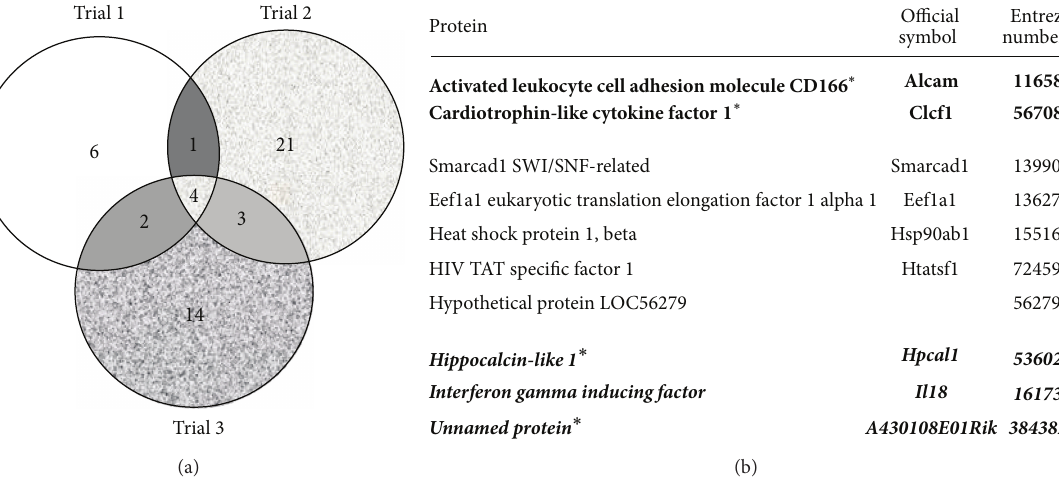
Figure 4: TCDD 120-minute treatment data set. (a) Venn diagram of proteins identified by mass spectrometry in 3 data sets of AHR-TAP 120 min TCDD (10nM) dosing. (b) Table listing of proteins identified in two out of three data sets. Bold type with ∗ denotes a protein represented in all three data sets. Italicized type denotes nonspecific proteins identified in both AHR-TAP and GFP-TAP samples.